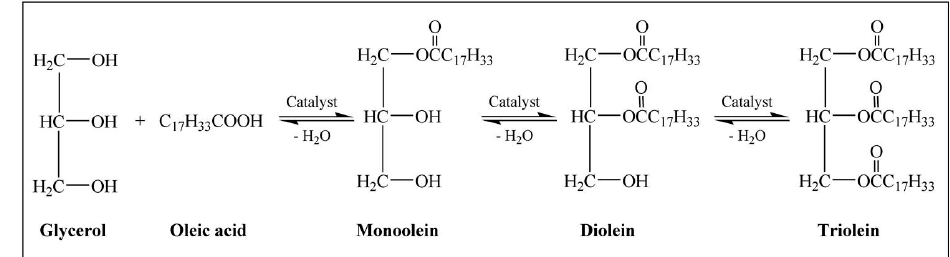
Scheme 1. Esterification of glycerol with oleic acid to produce olein products (isomers are not shown).